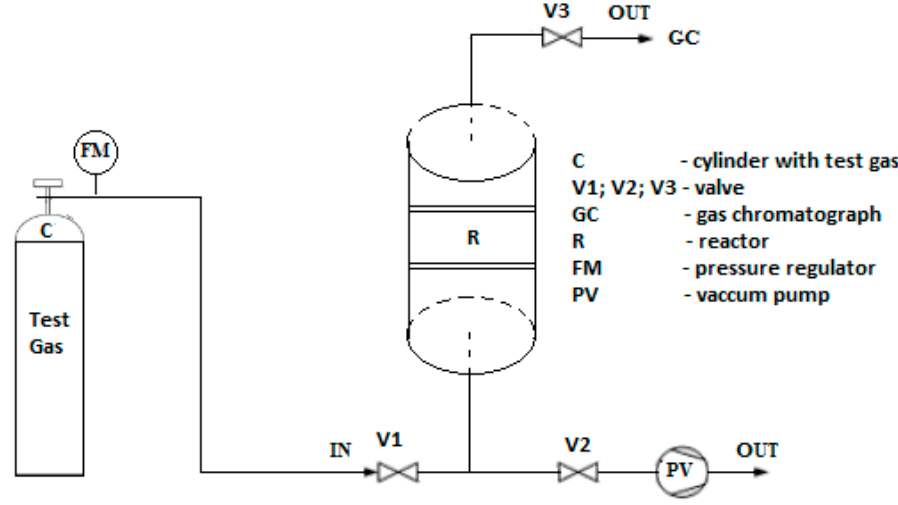
Figure 2. Flow sheet testing of selective adsorbent porous materials.